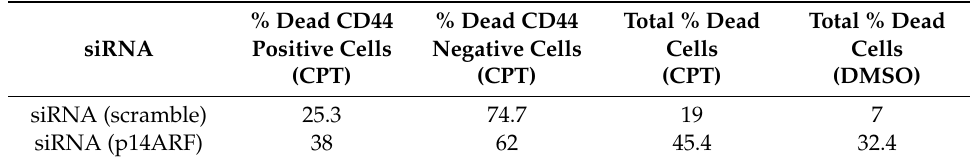
Table 1. p14ARF knockdown increases the camptothecin sensitivity of the cancer stem-cell-like Caco2 cells. Total % Dead Total % Dead % Dead CD44 % Dead CD44 Cells Cells Negative Cells siRNA Positive Cells (DMSO) (CPT) (CPT) (CPT) siRNA (scramble) 25.3 74.7 19 7 siRNA (p14ARF)